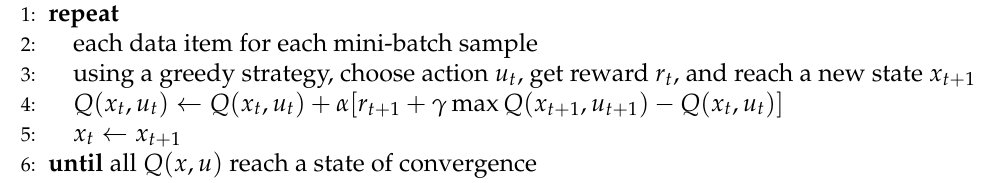
Algorithm 1 Q-learning